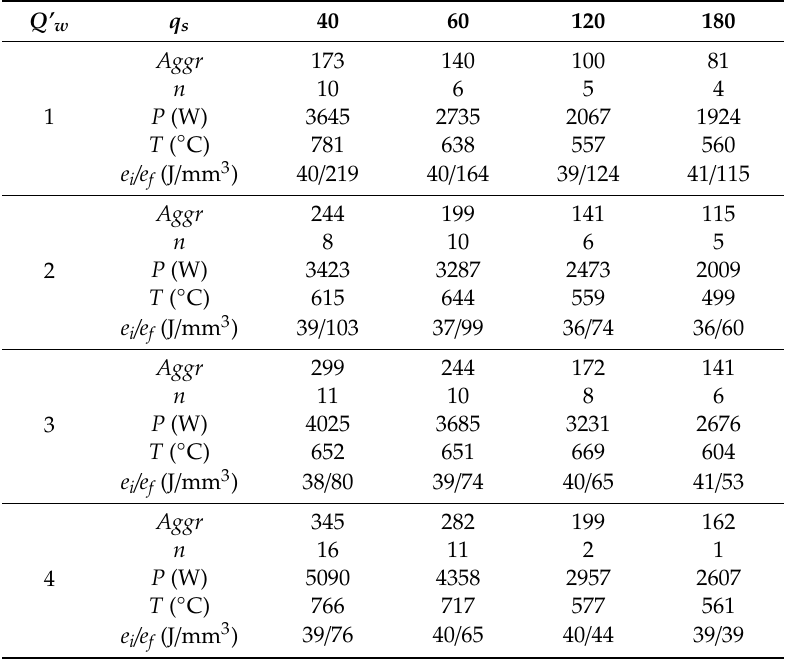
Table 4. Results from the tests to evaluate the influence of grinding conditions.